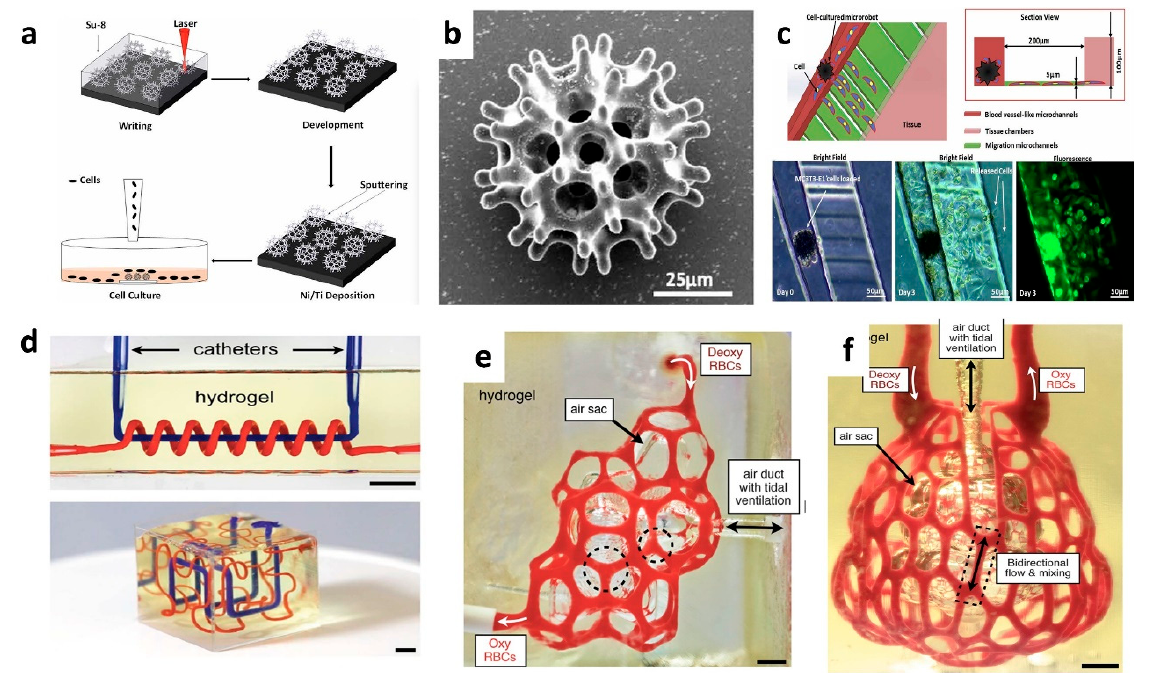
Figure 10. Applications 3D printing in the field of medicine. ( a – c ) Multi ‐ vascular and intravascular networks printed by hydrogel networks for ventilation process and oxygenation [132] and ( d – f ) fabrication process and morphology of the magnetic micro ‐ robot that can deliver cells [44].